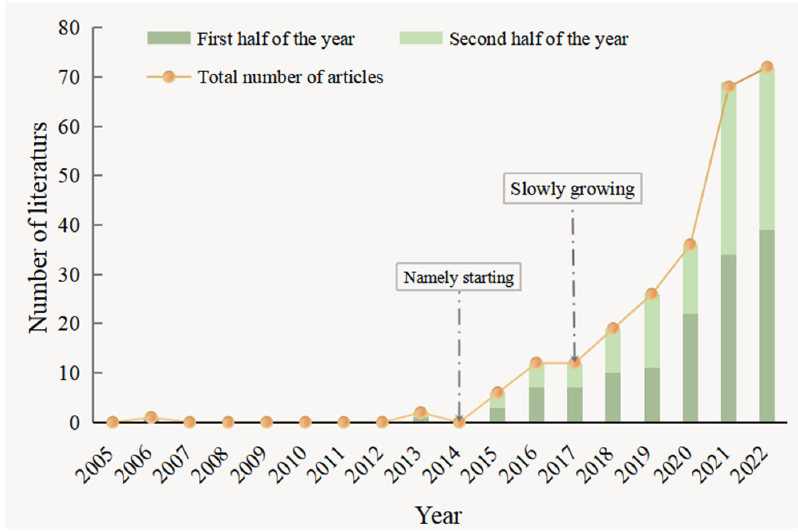
Figure 2. Annual distribution of the literature. The dark green is the first half of the year (January– June); the light green is the second half of the year (July–December).